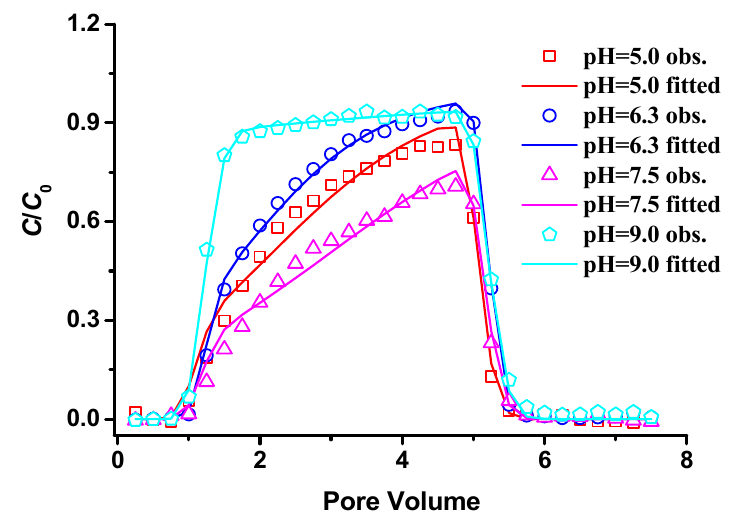
Figure 3. Observed (dots) and simulated (solid lines) breakthrough curves (BTCs) of GO at different solution pH as ω = 0.30 and IS = 1.0 mM KCl. Symbols are experimental data and solid lines are the fitted results obtained from the two ‐ site kinetic attachment model.